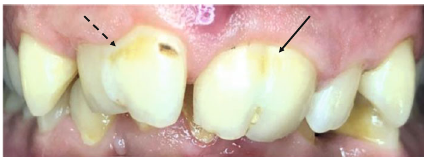
Figure 1: Preoperative image presenting geminated (arrow) and fused maxillary central incisors (dashed